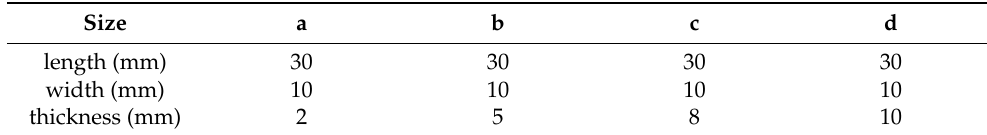
Table 3. Variation of the silica gel